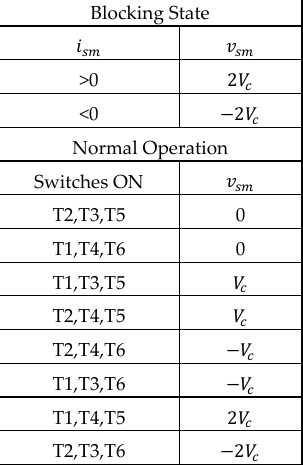
Figure 15. Figure 15. FLCCSM.